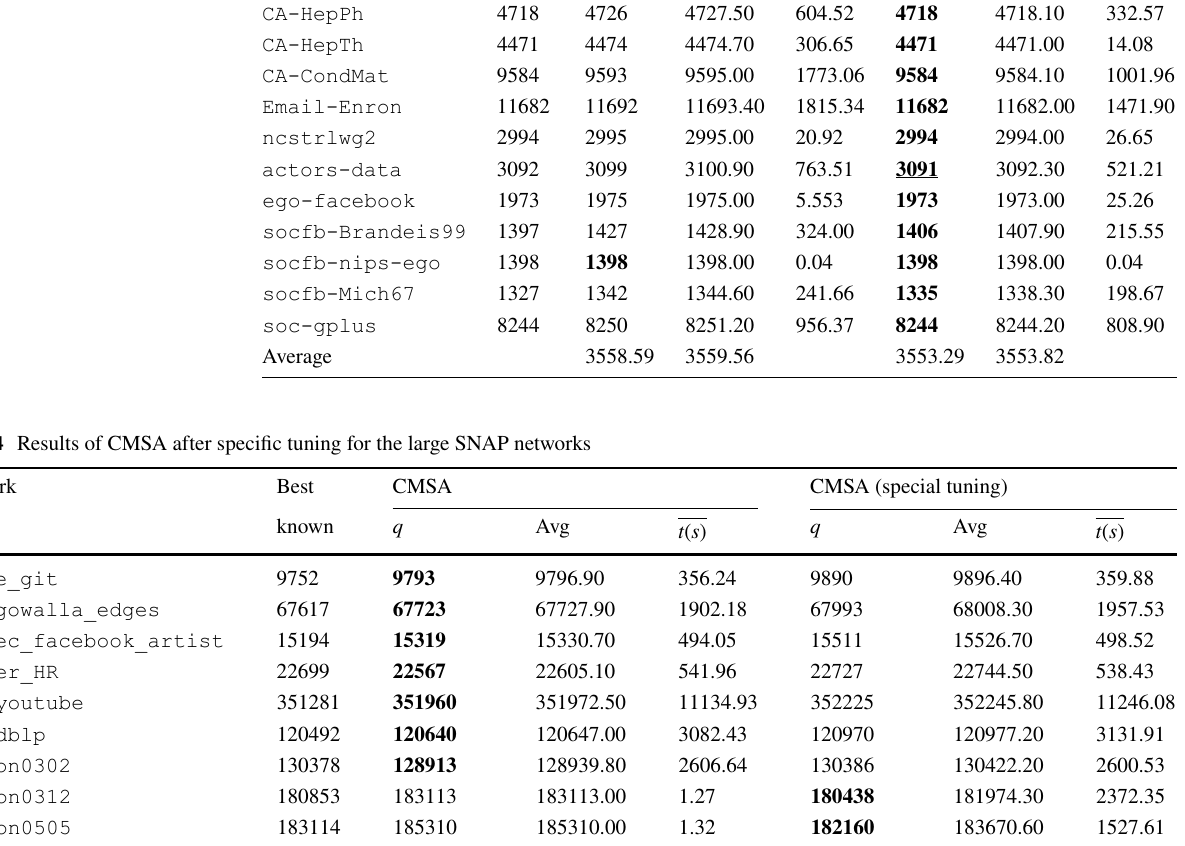
Table 3 Improvement of CMSA after specific tuning for small and medium size instances